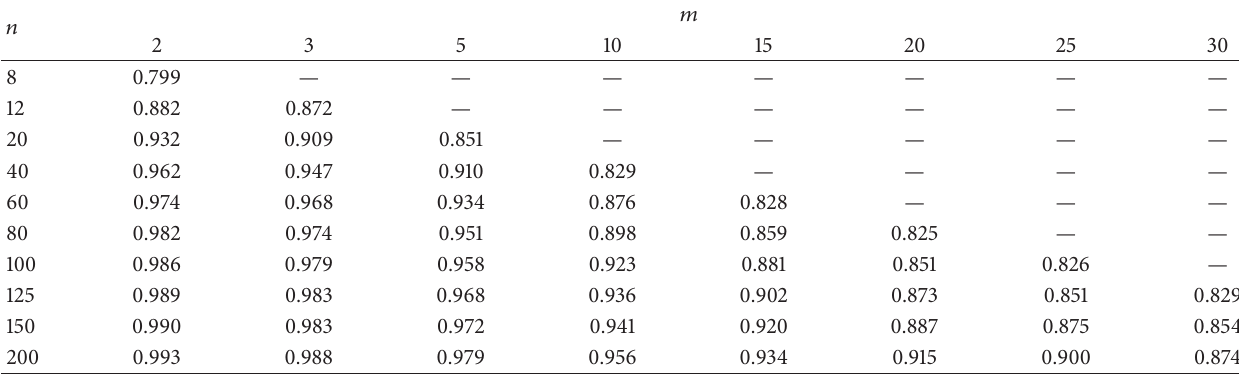
Table 1: Monte Carlo estimates of 𝜌 𝑚 .